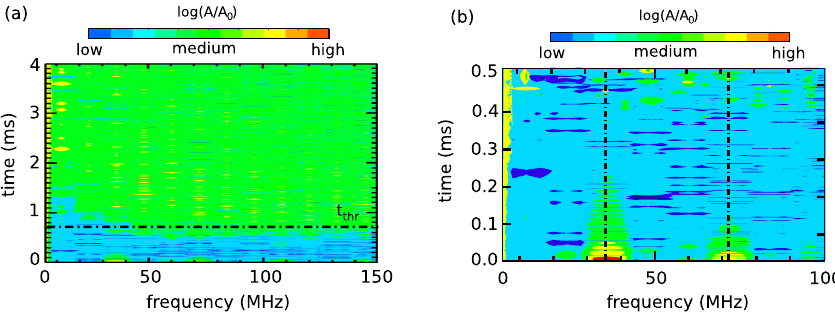
FIG. 9. Simulated frequency spectrum of the 40 Ar 18 þ measurement shown in Fig. 8. The dashed line in (a) indicates the time needed for the formation of the critical number of filaments t thr . In (b), the harmonics of the initial microbunches are